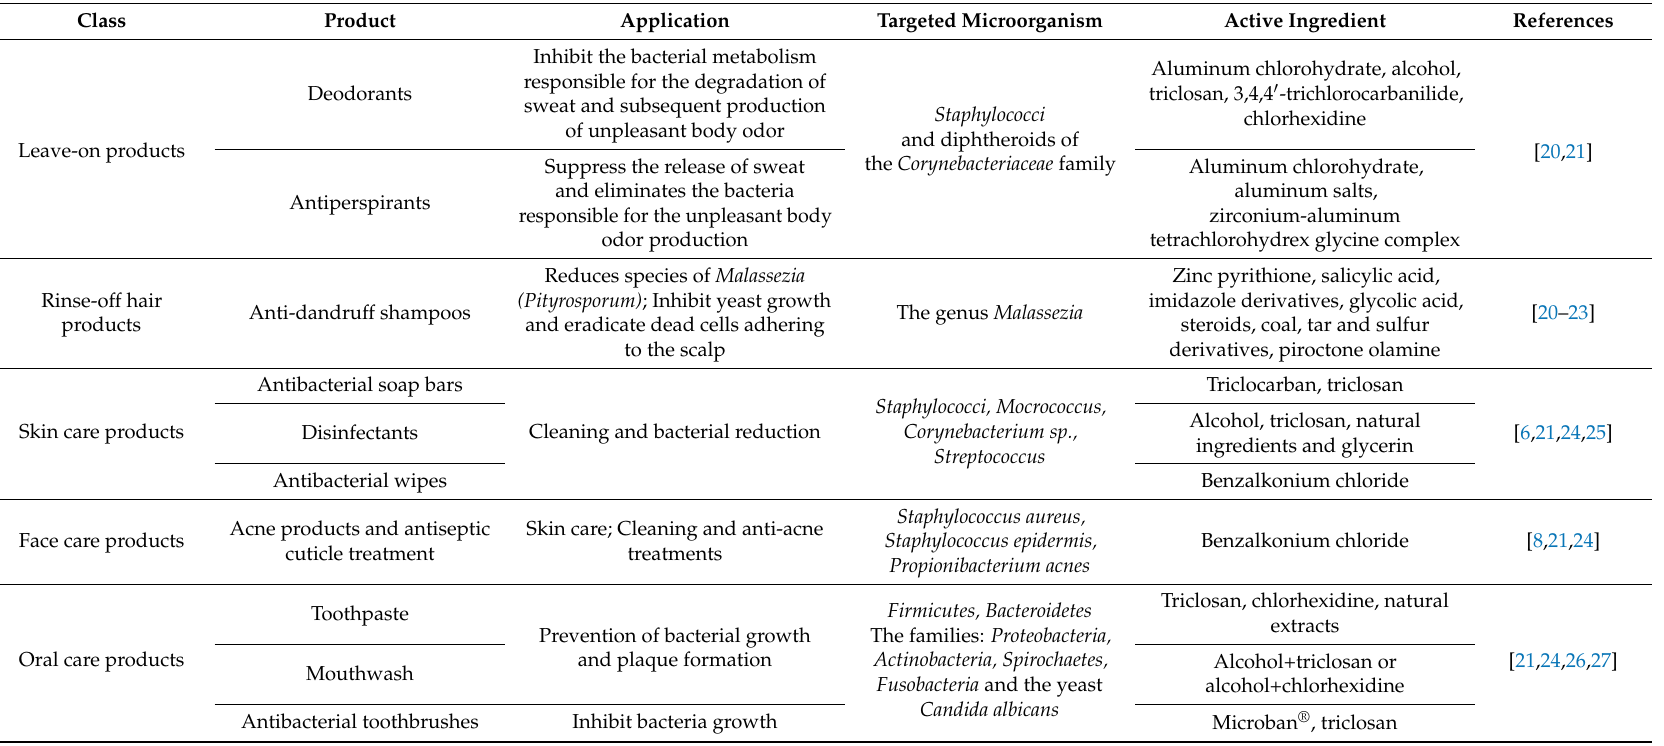
Table 1. Classification of cosmetic products with antimicrobial